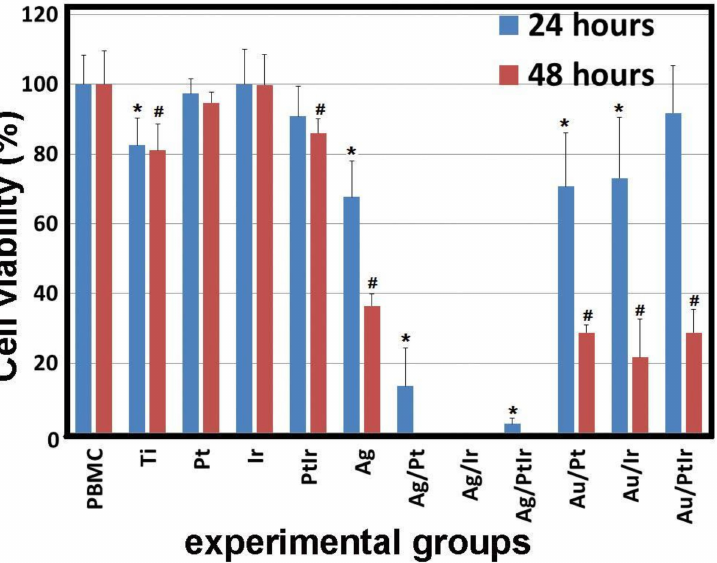
Figure 7. Viability of PBMC human cells after 24 and 48 h of cultivation in the presence of series samples (Ti-alloy with various combinations of metals on films); * p < 0.05 compared with control (for groups of 24 h), # p < 0.05 compared to control (for groups of 48